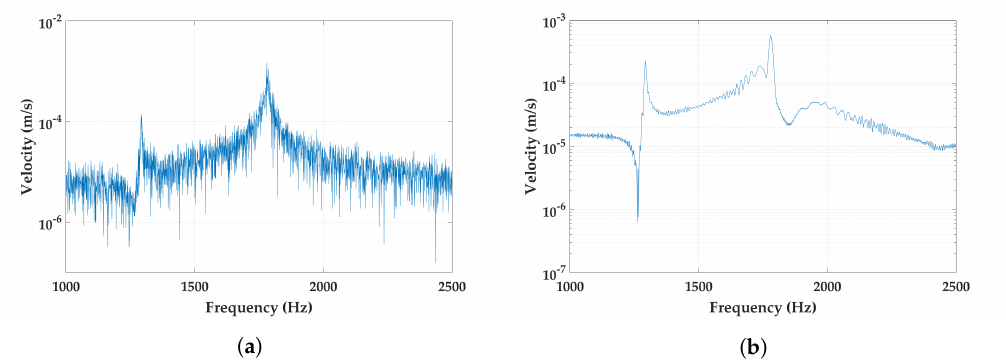
Figure 10. Characterization of M-shape in a laser doppler vibrometer (LDV) setup in different excitation signals: ( a ) Gaussian white noise of 0.1 V amplitude; and ( b ) periodic chirp voltage of 0.1 V. Both measurements show the same resonance frequencies.